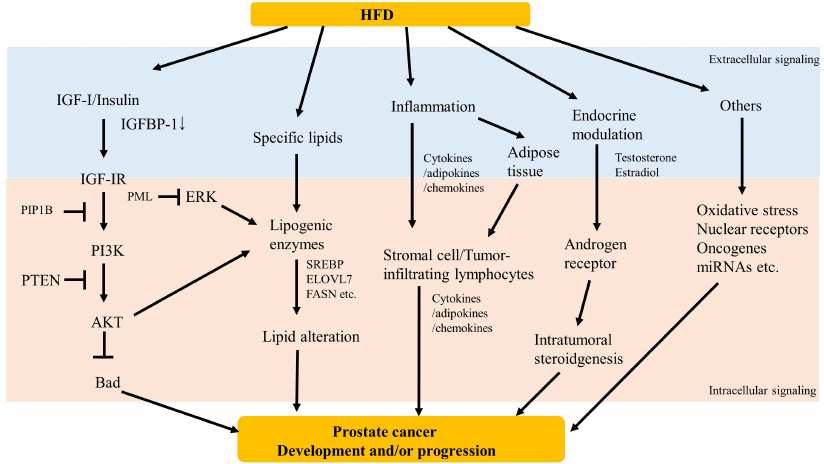
Figure 1. Scheme of potential mechanisms underlying high-fat diet induced prostate cancer development and / or